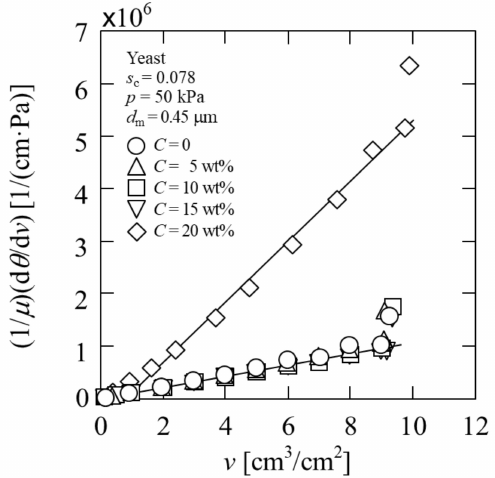
Figure 3. Microfiltration behavior of yeast suspension ( C = 0–20